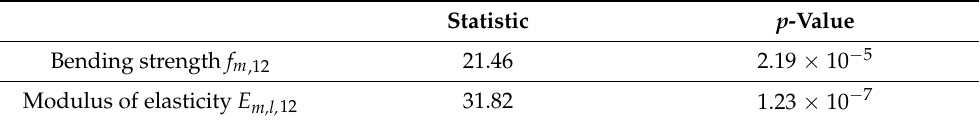
Table 7. Kruskal–Wallis test results.